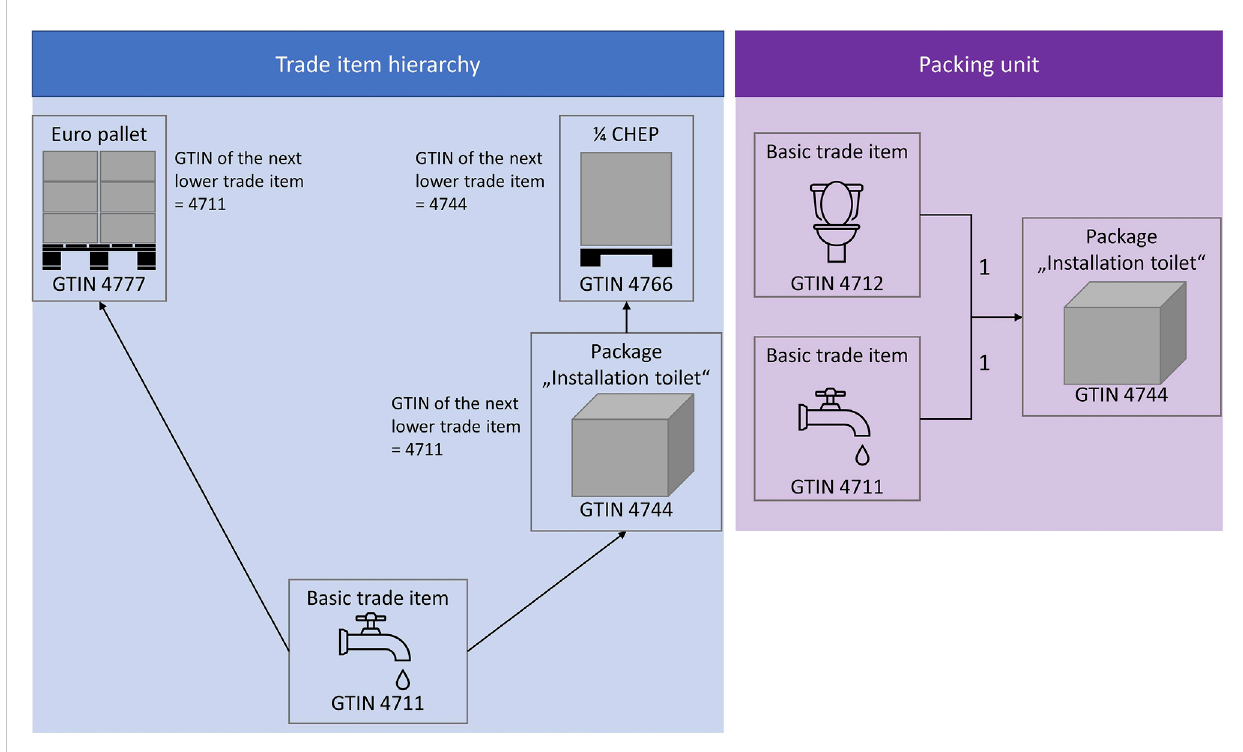
FIGURE 6 Exemplary trade item hierarchy with Global Trade Item Numbers